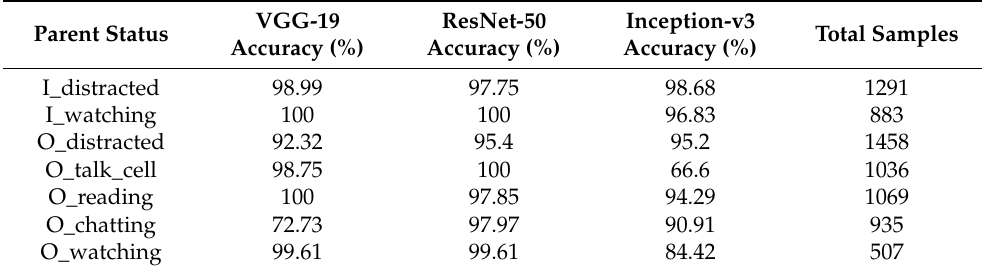
Table 5. Accuracy of each model with each category.